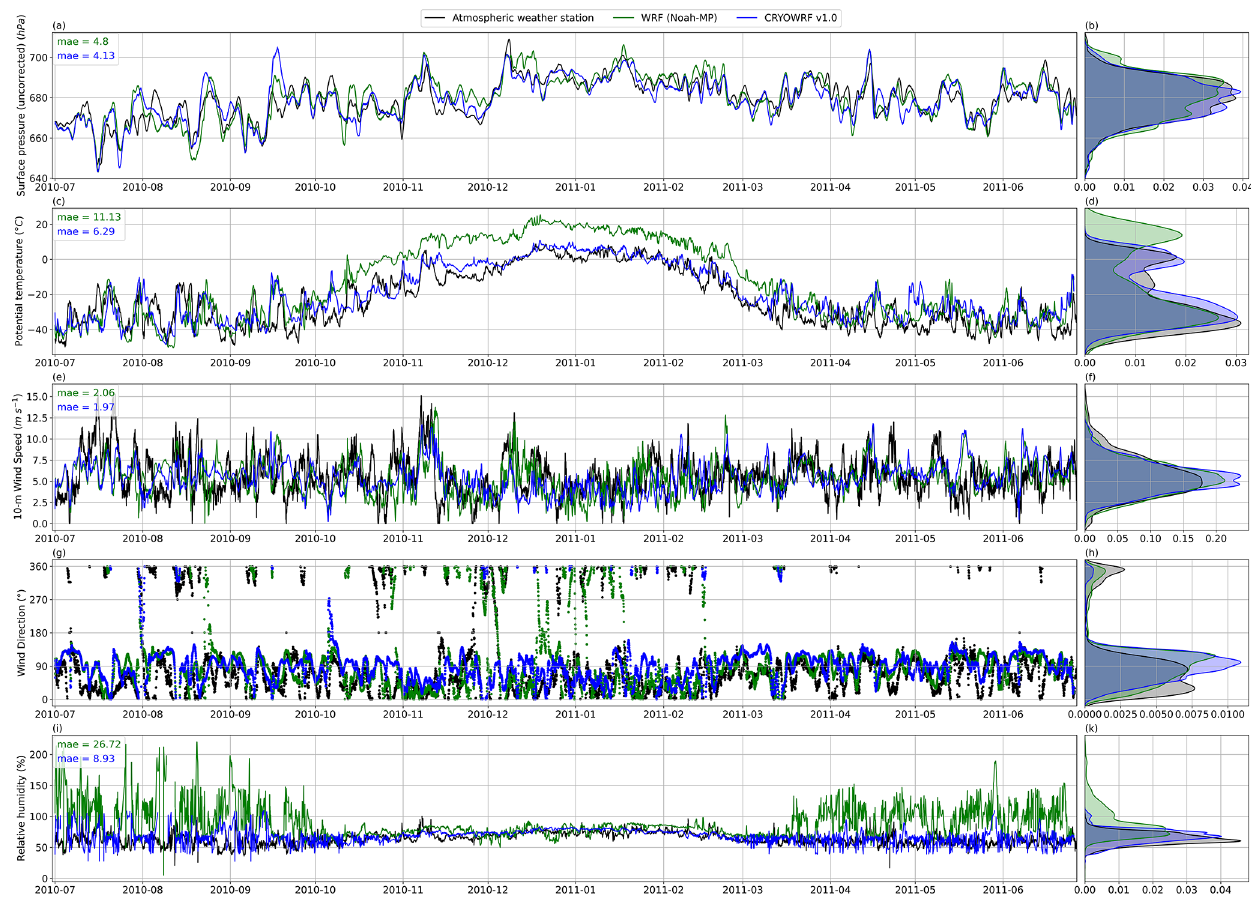
Figure 6. Time series comparison between CRYOWRF, Noah-MP, and measurements using the automatic weather station at the South Pole for surface pressure (a) , 2m potential temperature (c) , 10m wind speed (e) , wind direction (g) , and relative humidity (with respect to ice) (i) . The distributions of these quantities over a period of 1 year are shown in the adjoining figure on the right in each row (b, d, f, h, k) .